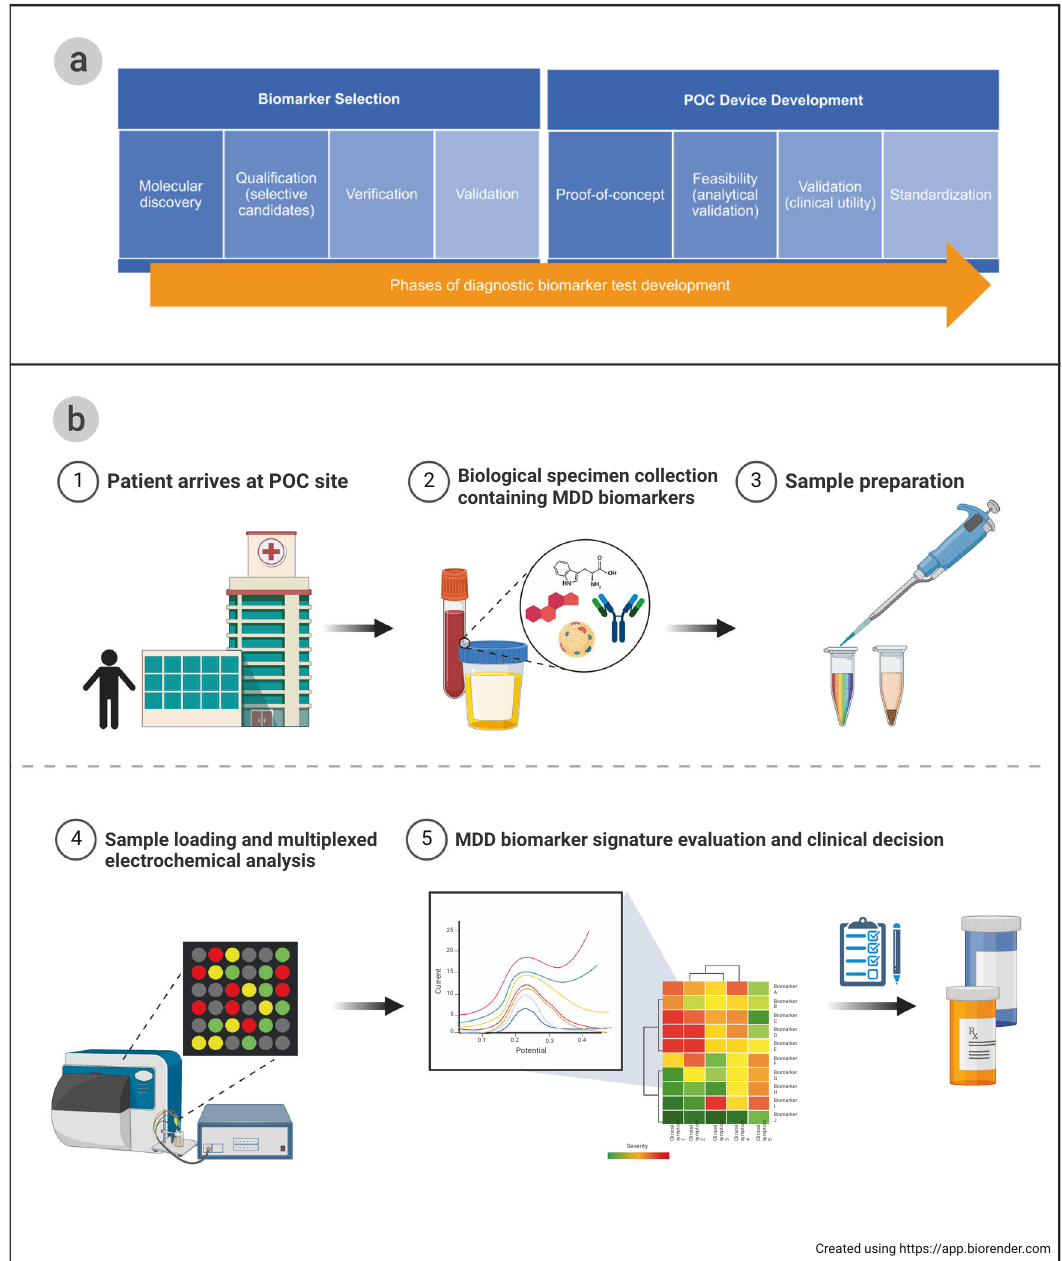
Fig. 1 Lifecycle and application of a point-of-care diagnostic device. a Process of developing a POC diagnostic device and b fl ow diagram of utilizing a POC diagnostic device for clinical decision making. The fi gure was created with response. Other panels have included clinical imaging and socioeconomic parameters alongside proteomic data to screen for subthreshold depression and moderate predictive ability for escalating to MDD, providing a pathway by which biomarker data are integrated into a multi-faceted, panel-based approach [30, 31]. At this point, the evidence for any individual biomarker is not robust; a panel-based approach may solve issues of validity and speci fi city to depression. Current point-of-care technologies for diagnosis We propose that a panel-based POC diagnostic test for MDD is likely the most optimal method to address both research and clinical needs. POC diagnostic tests aim to provide more